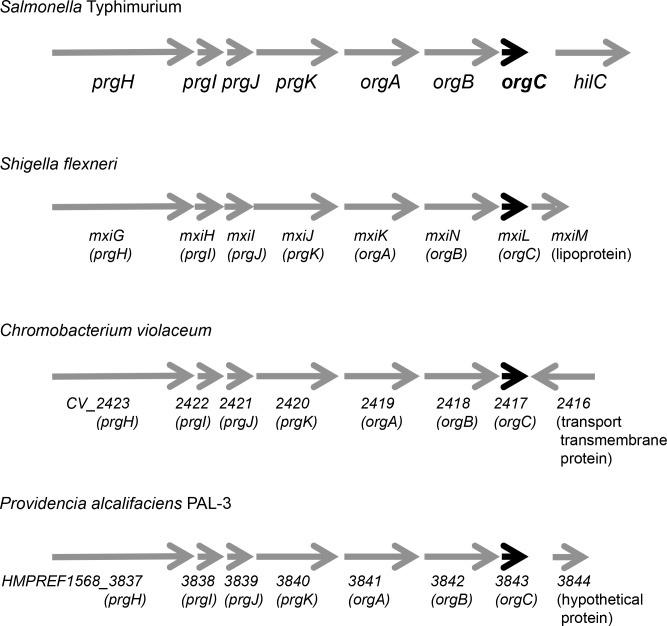
Genetic organization of different T3SS loci encoding OrgC homologs.